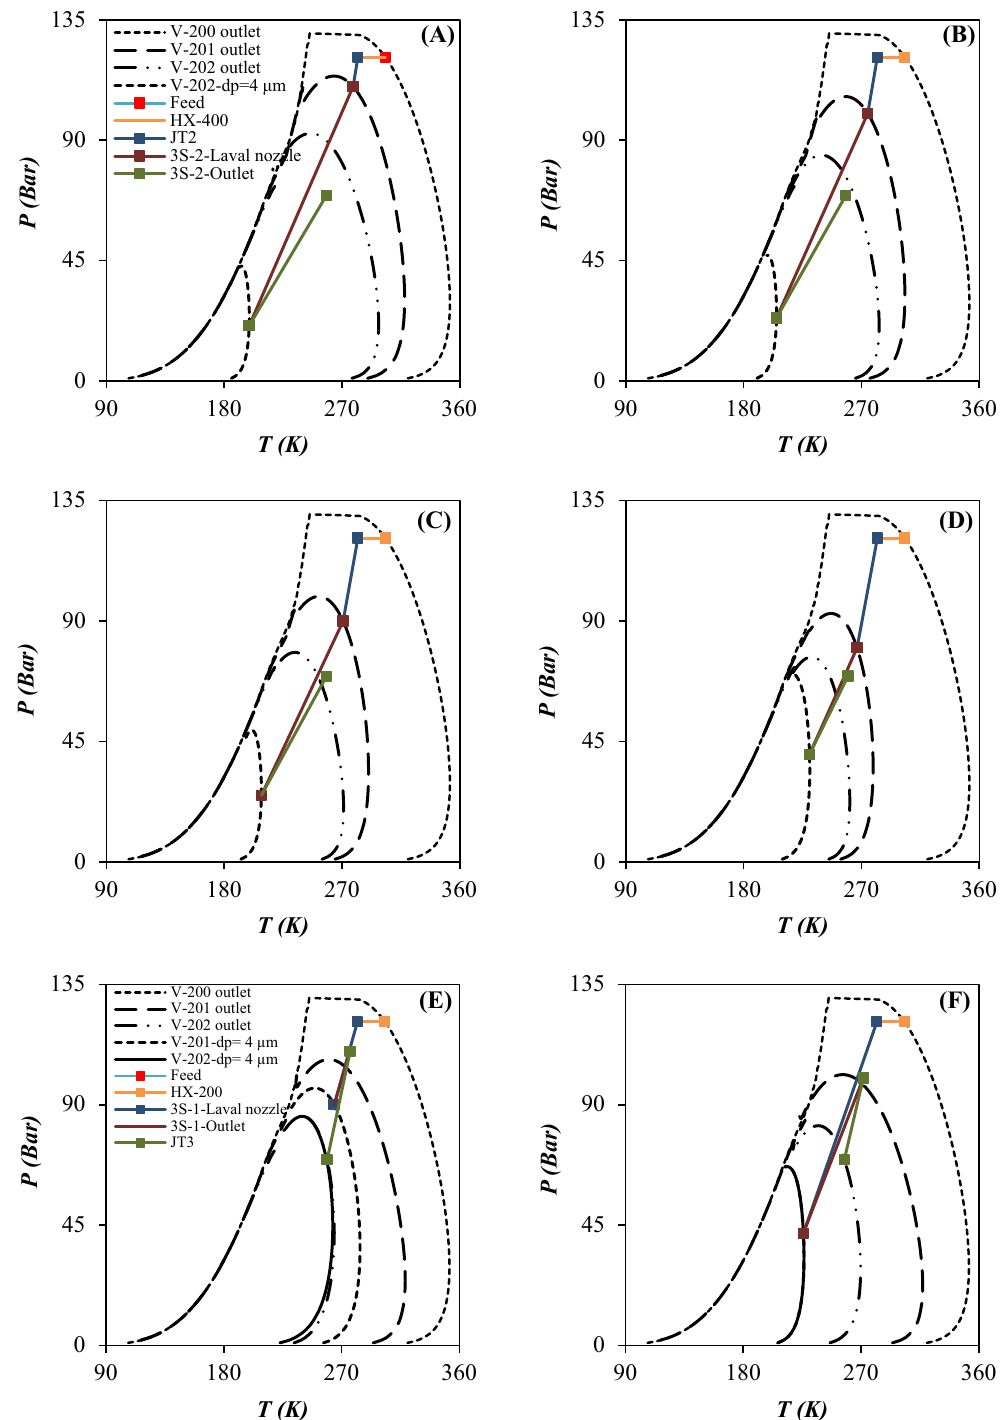
Figure 11. PED for configuration B ( A–D ) and C ( E–H ): ( A, E ) Scenario 1, ( B, F ) Scenario 2, ( C, G ) Scenario 3 and ( D, H ) Scenario